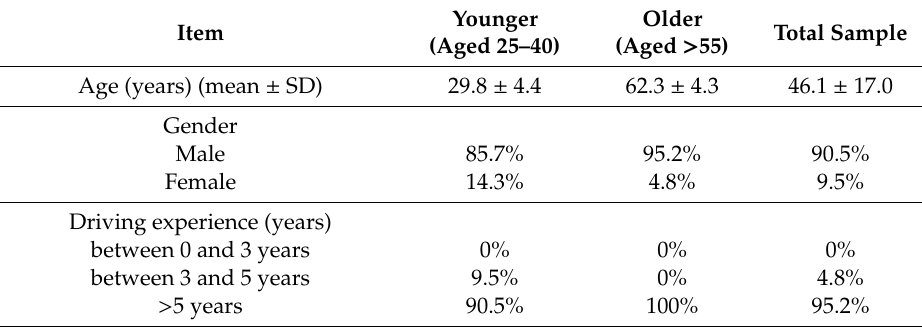
Table 1. Demographic characteristics for the total sample and the two age